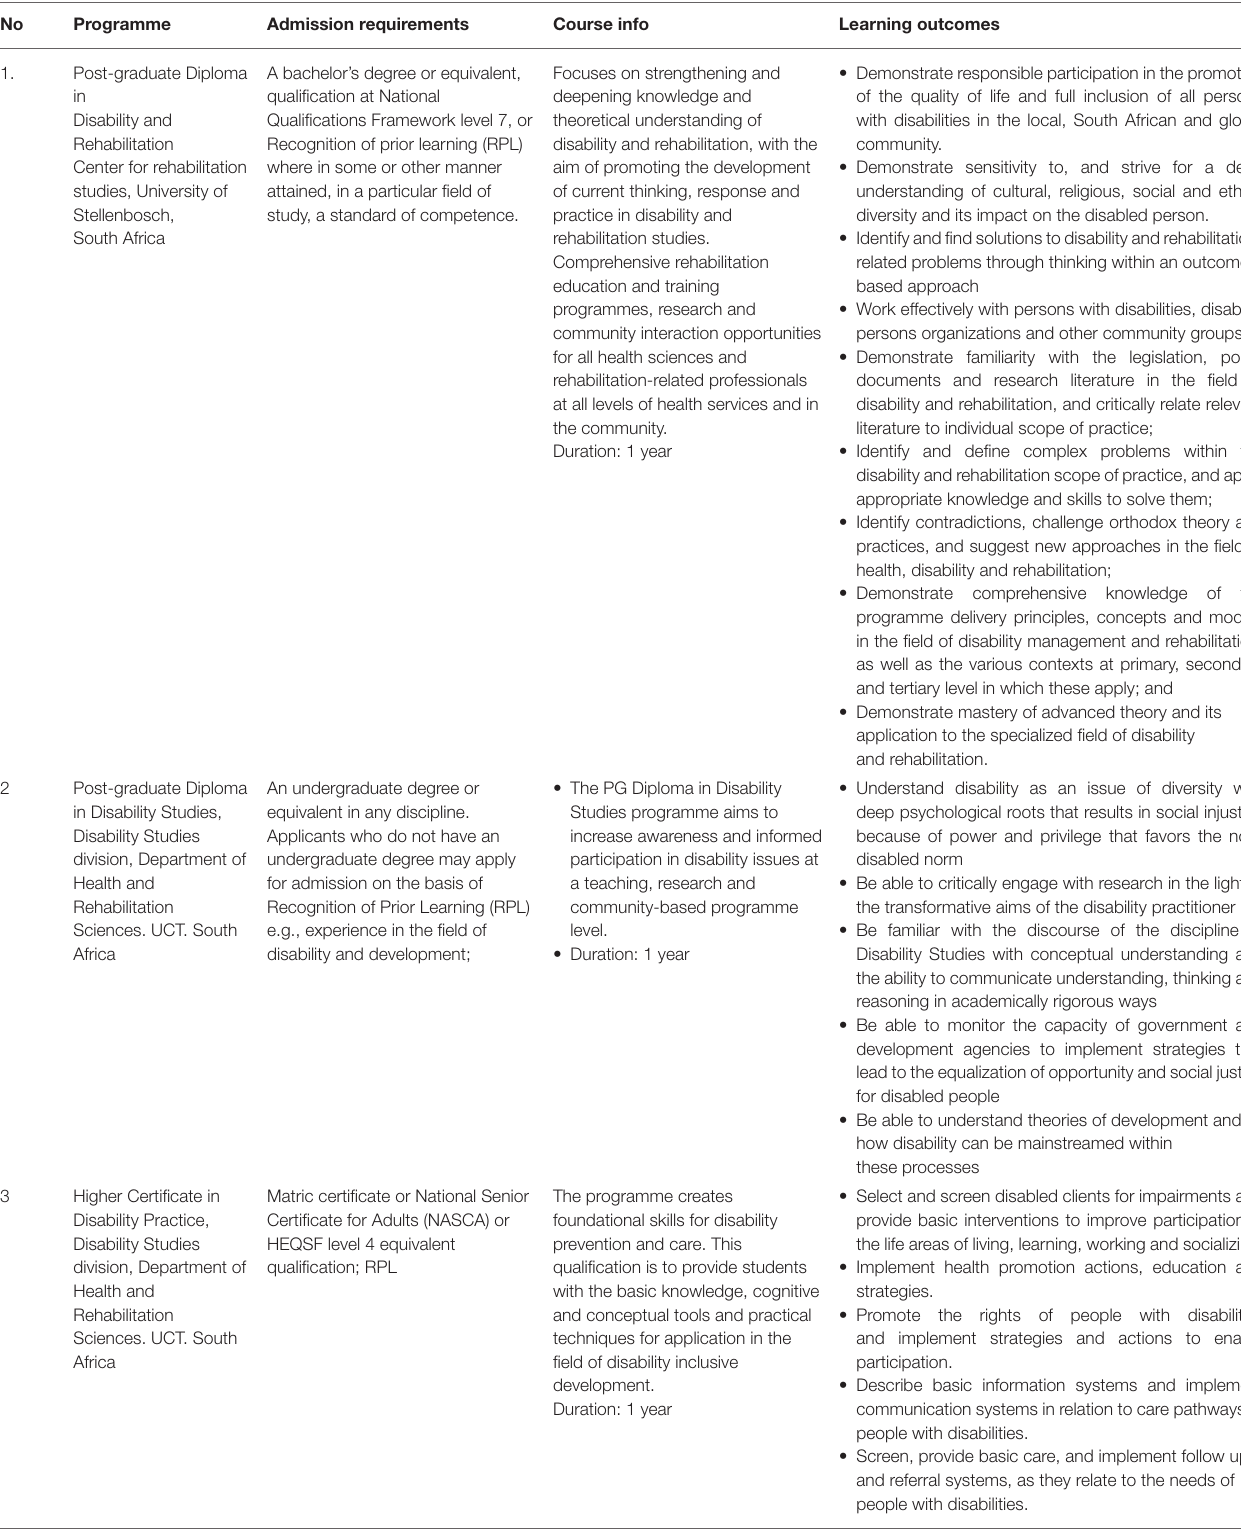
TABLE 1 | Details of formal training currently